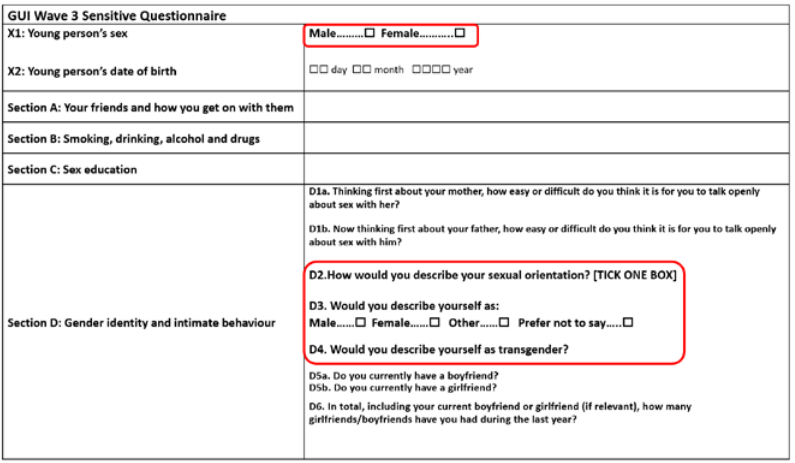
Figure 1. Growing Up in Ireland Wave 3 Sensitive Questionnaire overview of Sections A–D, with placement of questions on sex, sexual orientation, gender and transgender identity highlighted.